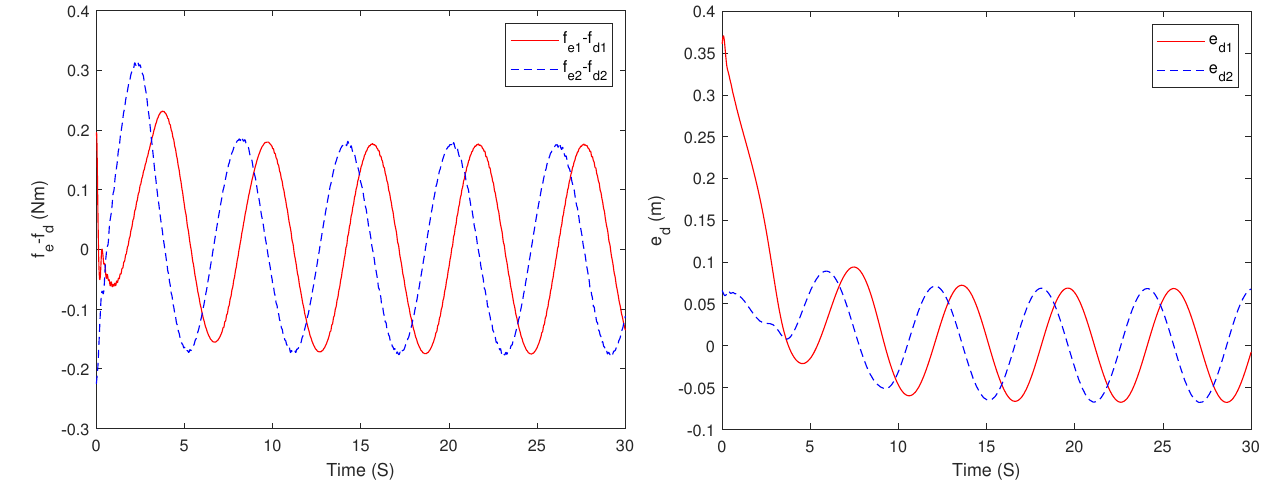
Figure 8. The performance of the desired trajectory tracking error and the interactive